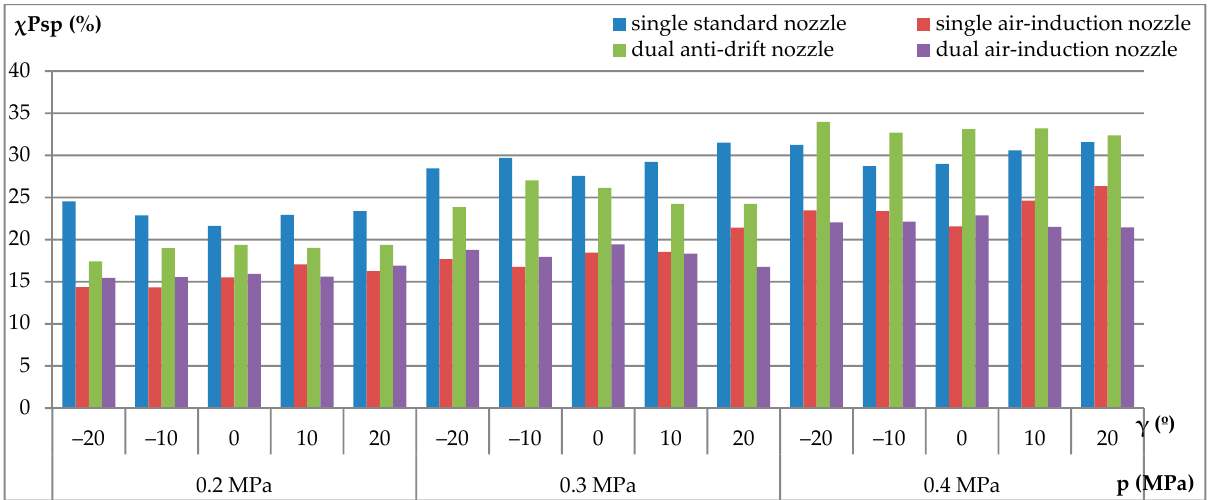
Figure 2. Average degree of coverage for selected nozzles at 1.1 m ∙ s − 1 driving speed.